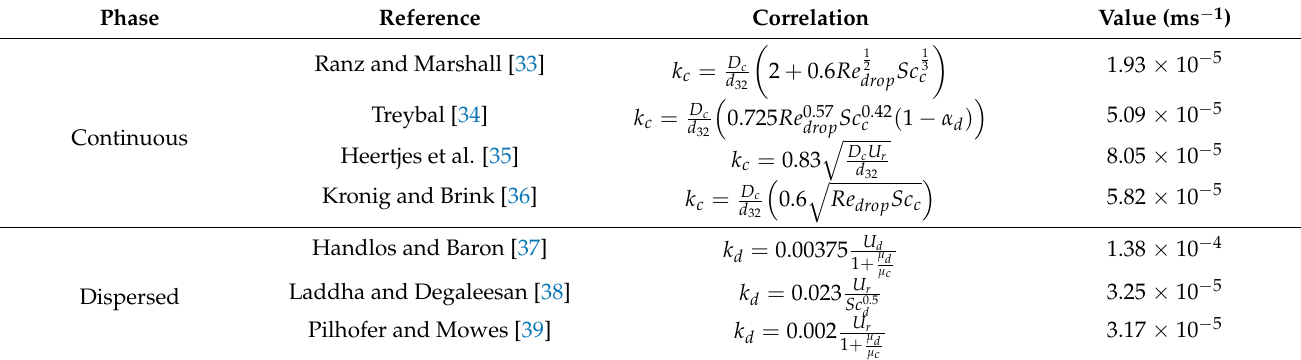
Table 1. Correlations used to evaluate the phase-specific mass transfer coefficients (summarised from [26]) employed in estimating k c and k d for: d 32 = 2.9 × 10 − 3 m, U s = 0.025 ms − 1 , α =